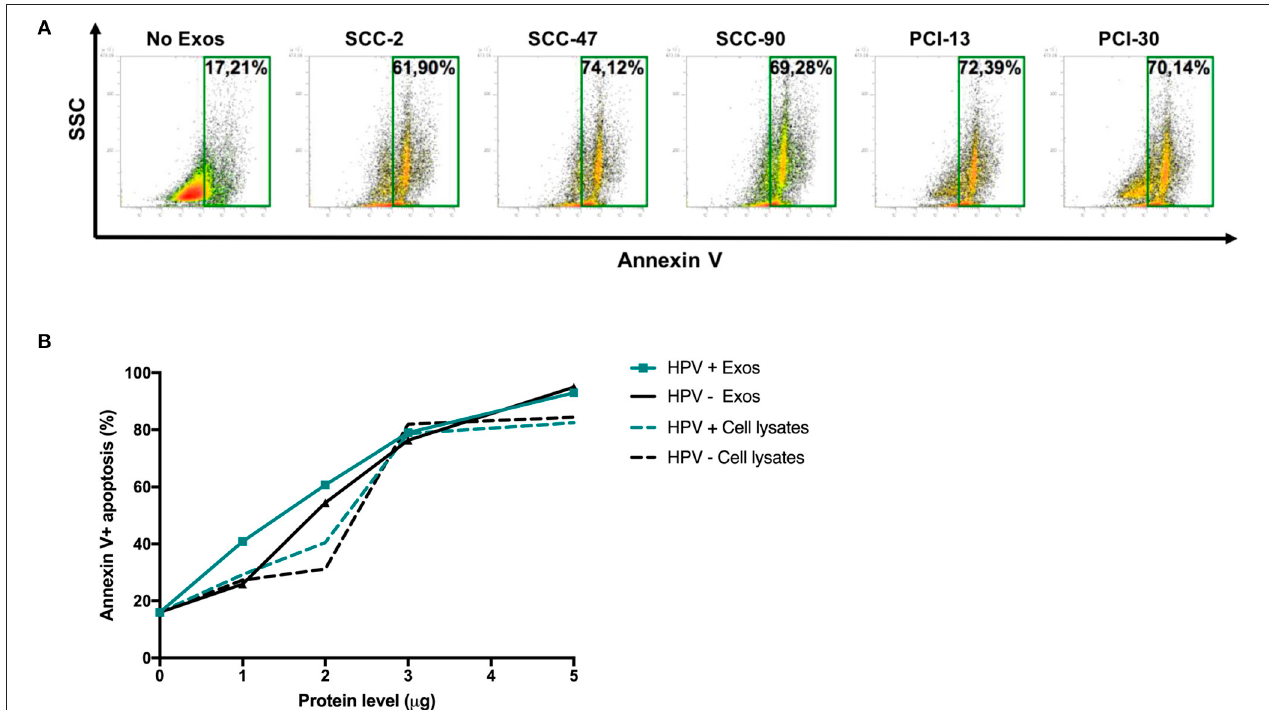
FIGURE 5 | Exosome-induced apoptosis of CD8 + Jurkat cells. (A) Representative flow cytometry data for Annexin V-stained CD8 + Jurkat cells incubated with exosomes or PBS as control for 24h. (B) Cumulative data from experiments in which CD8 + Jurkat cells were co-incubated with increasing protein levels of exosomes isolated from supernatants of HPV( + ) or HPV( − ) cell lines or with lysates of these cell